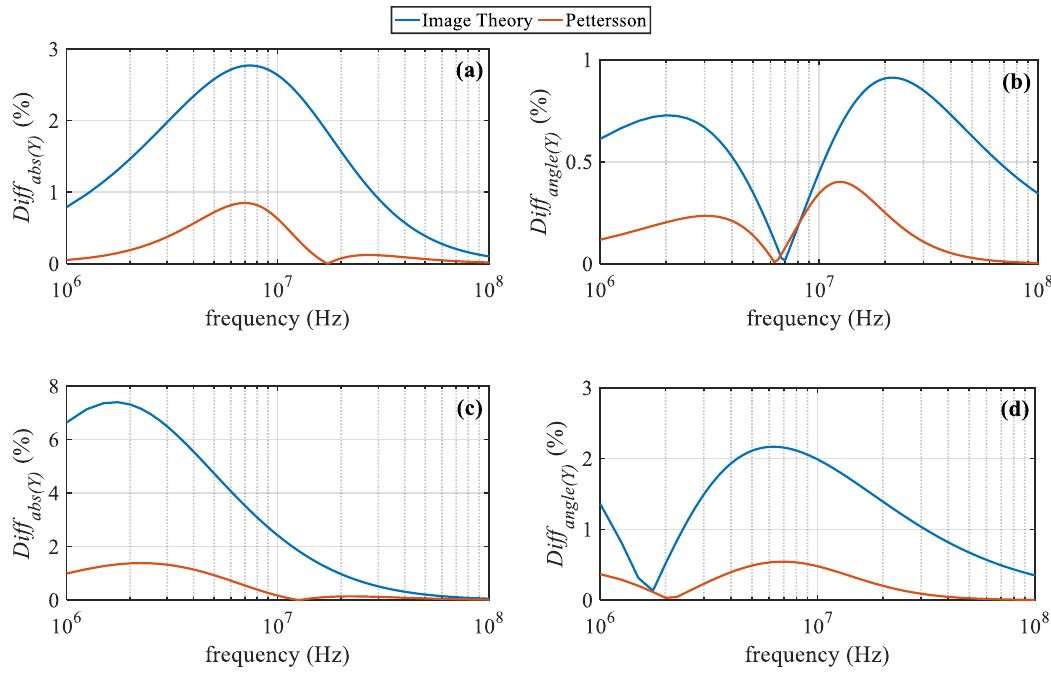
Figure 20. Di ff erences in Y 13 at the BB frequency zone. For ρ g = 100 Ω m, ε rg = 10, ( a ) magnitude, ( b ) angle, for ρ g = 1000 Ω m, ε rg = 10, ( c ) magnitude and ( d ) Figure 20. Differences in Y 13 at the BB frequency zone. F or ρ g = 100 Ωm, ε rg = 10, ( a ) magnitude, ( b ) angle, for ρ g = 1000 Ωm, ε rg = 10, ( c ) magnitude and ( d ) angle.